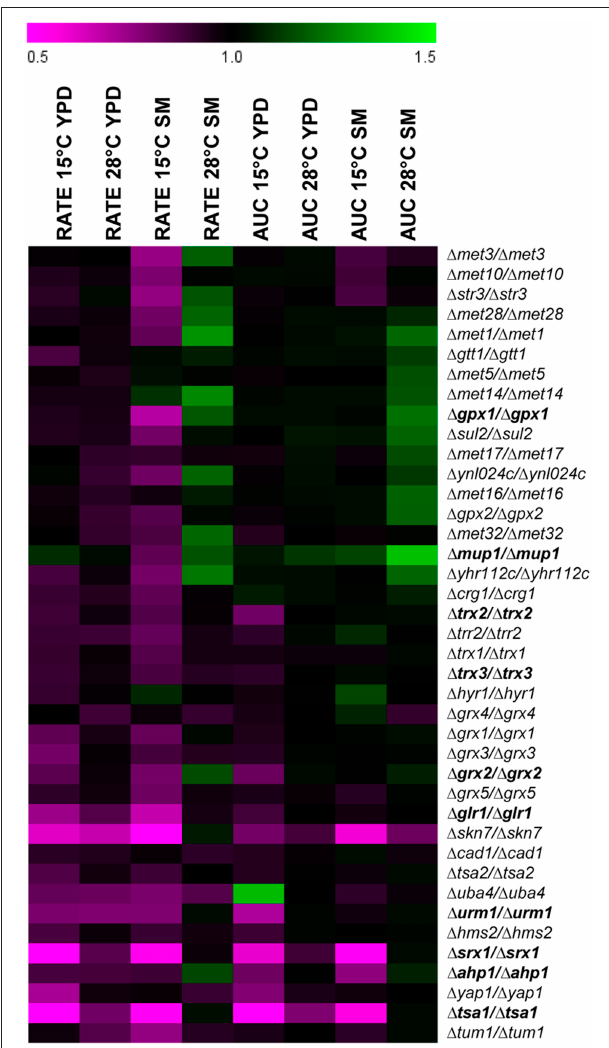
FIGURE 3 | Growth parameters (rate and AUC) of 40 mutants strains of the BY4743 collection related to oxidative stress response. The values are relative compared with control strain BY4743. Values below 1 meant that the parameter was affected compared with the control strain. Sensitivity is indicated in purple, and resistance in green. The mutants in bold were selected for their construction in the wine strains.